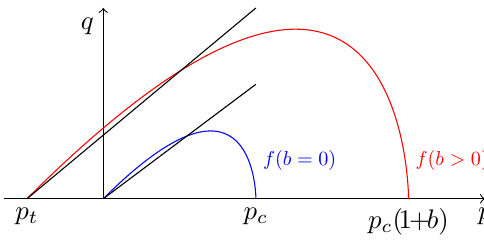
Figure 9. Yield surfaces in the ( p , q )